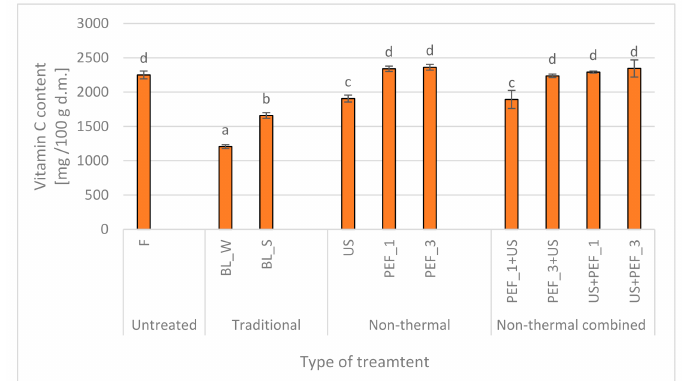
Figure 2. Vitamin C content in fresh (F) red bell peppers and subjected to traditional (blanching in water, BL_W, and blanching in steam, BL_S) and non-thermal single treatment (US—ultrasound, PEF_1 and PEF_3—pulsed electric field with energy input 1 and 3 kJ / kg, respectively) and combined treatment (PEF + US and US + PEF), the same letters indicate homogeneous groups (Tukey’s HSD, p < 0.05), the error bars represent the standard deviation calculated from 3